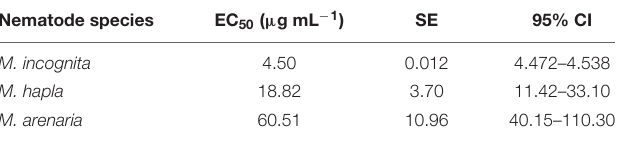
TABLE 2 | EC 50 values ( µ g mL − 1 ) for cyclopiazonic acid-induced mortality of Meloidogyne incognita, Meloidogyne hapla, and Meloidogyne areaniana after 72 h of nematode immersion in test solution with respective SE and 95% CI values.